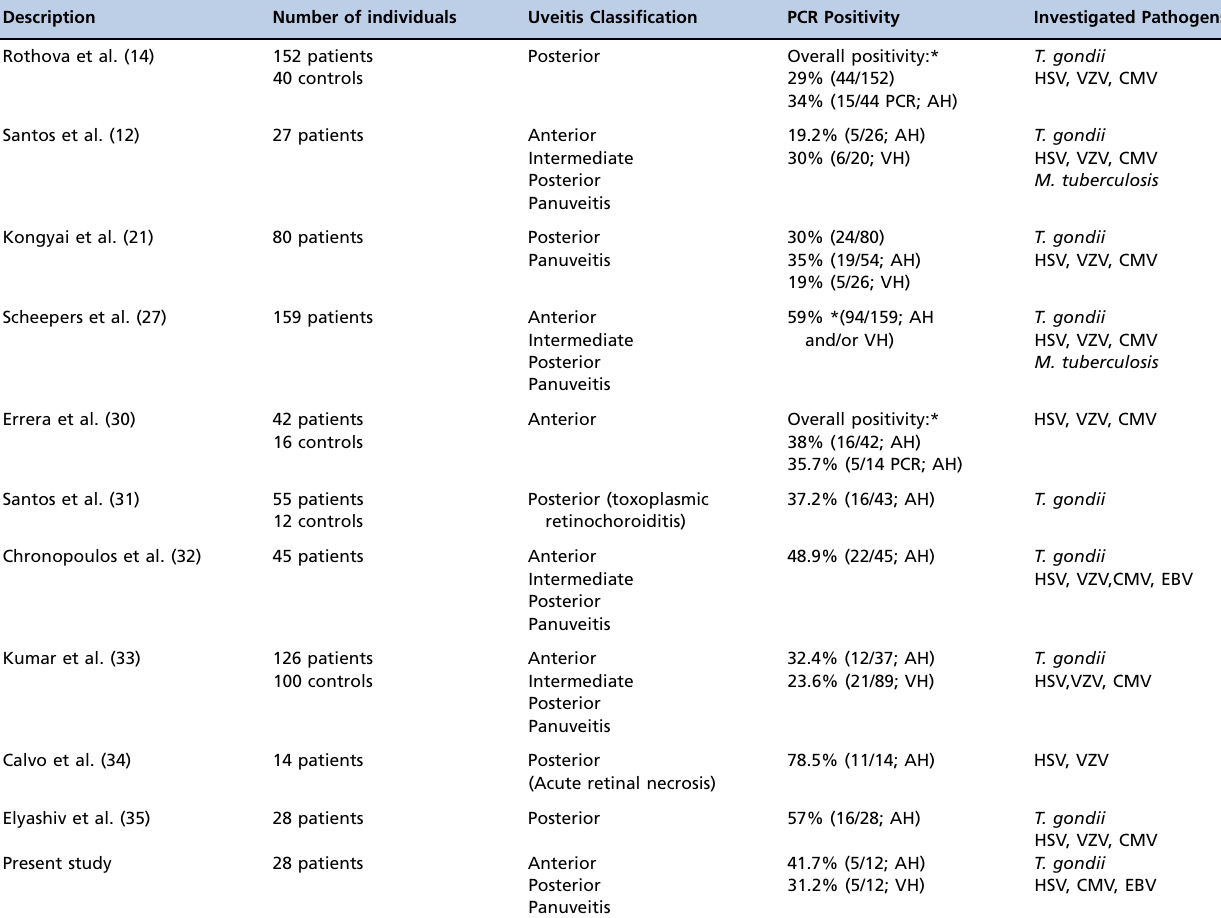
Table 2 - Summary of similar studies in the literature, including the present study results, with aqueous and/or vitreous humor analysis in patients with